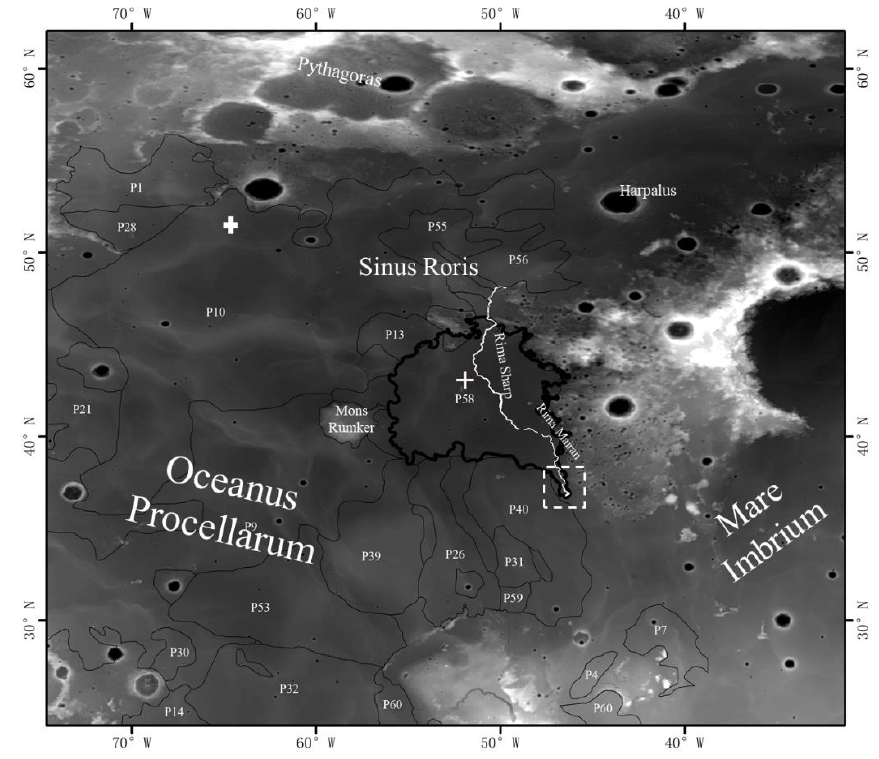
Figure 1. The location of the Chang’e-5 landing area and the spatial extent of this study (dashed box). The base map is Chang’e-2 (CE-2) DEM data.